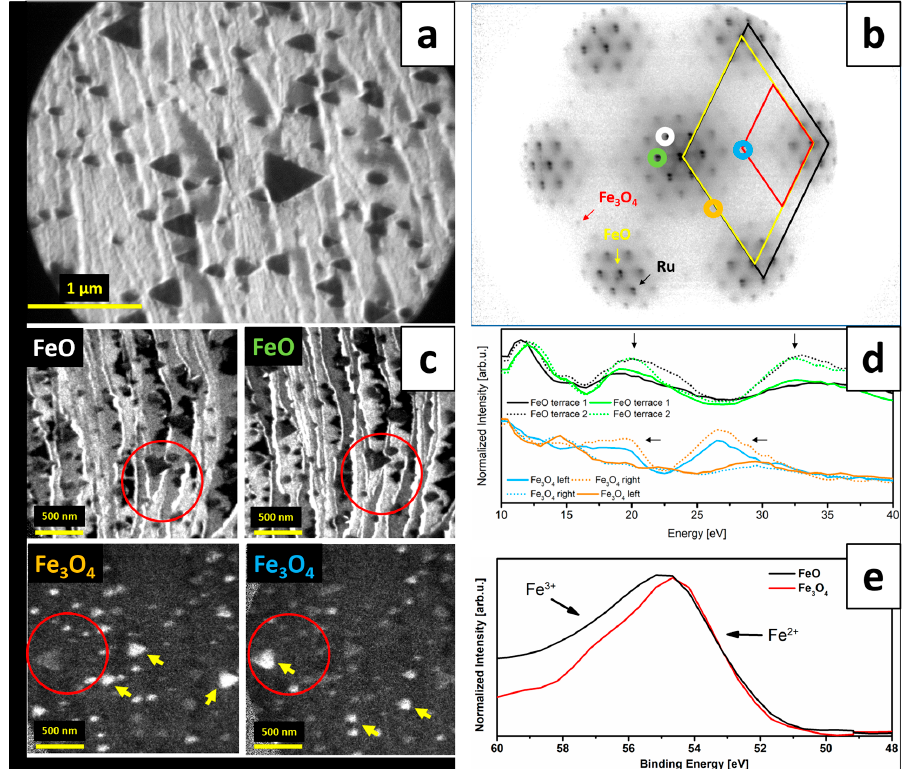
Figure 3. LEEM image (energy: 10 eV) ( a ) and µLEED pattern (energy: 42 eV) ( b ) of iron oxide structures grown on Ru(0001) by ~1.9 MLs Fe deposition under UHV at RT and post-oxidation in 1 × 10 − 6 mbar O 2 at 900 K; the Ru(0001), FeO(111) and Fe 3 O 4 (111) unit cells are marked on the µLEED pattern with black, yellow and red rhombuses, respectively; ( c ) presents DF-LEEM images (red circles mark the same sample position) obtained by using the diffraction spots of FeO(111) (imaging energy: